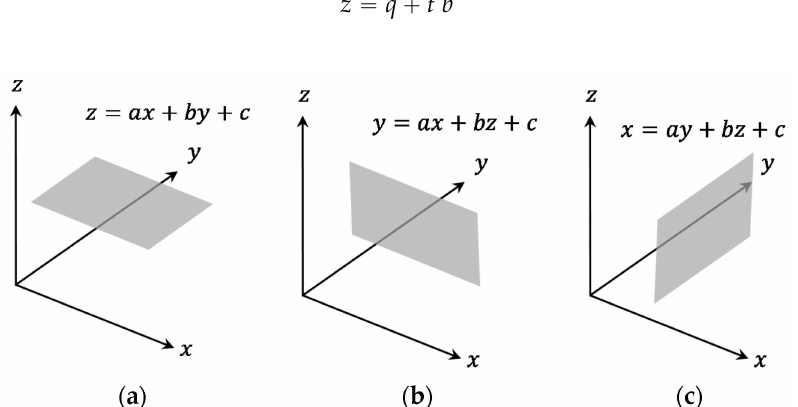
Figure 2. Representation scheme for 3D planar features; planes that are almost parallel to the xy ´ plane ( a ); planes that are almost parallel to the xz ´ plane ( b ); and planes that are almost parallel to the yz ´ plane ( c ).